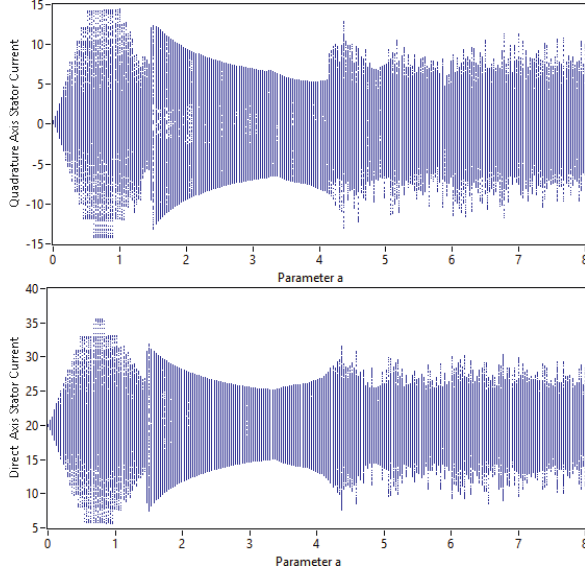
Fig. 5: Bifurcation of Quadrature axis versus ‘ a ’ and Direct axis cur- rent versus ‘ a ’.